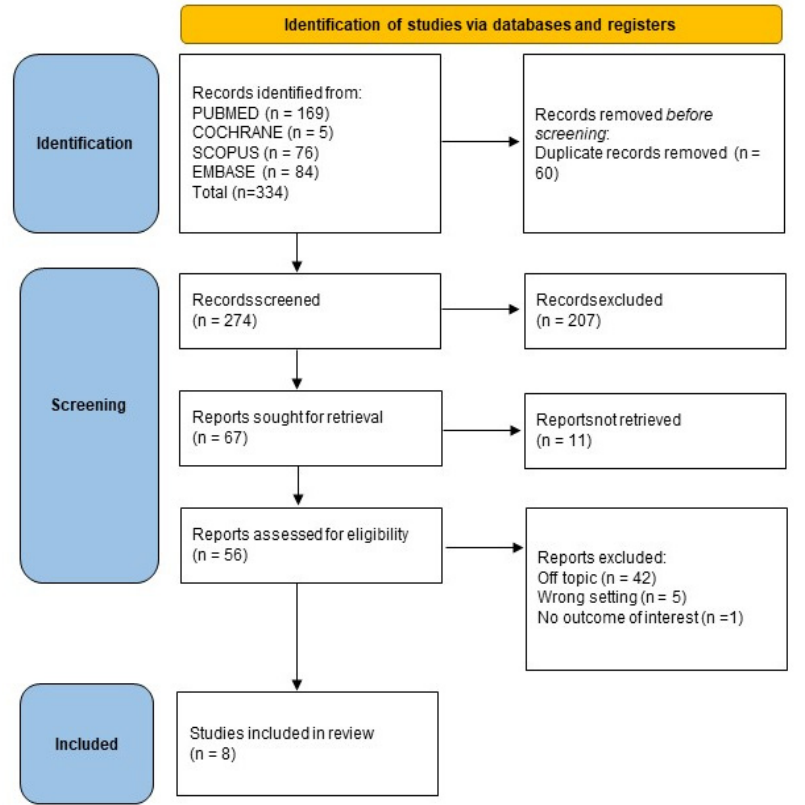
Figure 8. Literature search preferred reporting items for systematic reviews and meta-analyses (PRISMA) flow diagram.